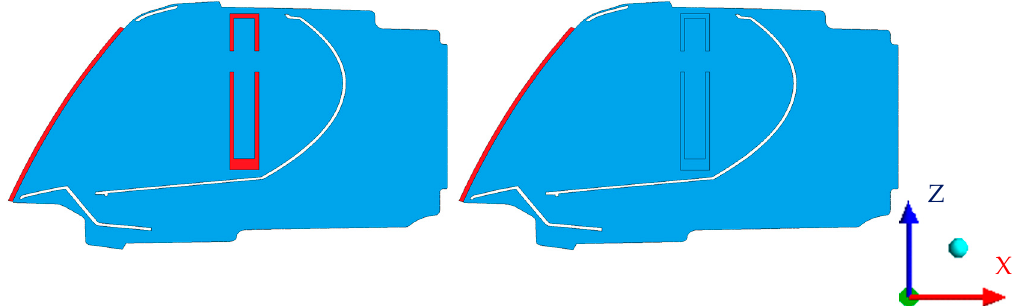
Figure 5. Cross section of the domain. ( left ) simulation of fogging (preparative stage); ( right ) simulation of defogging (evaluated stage).